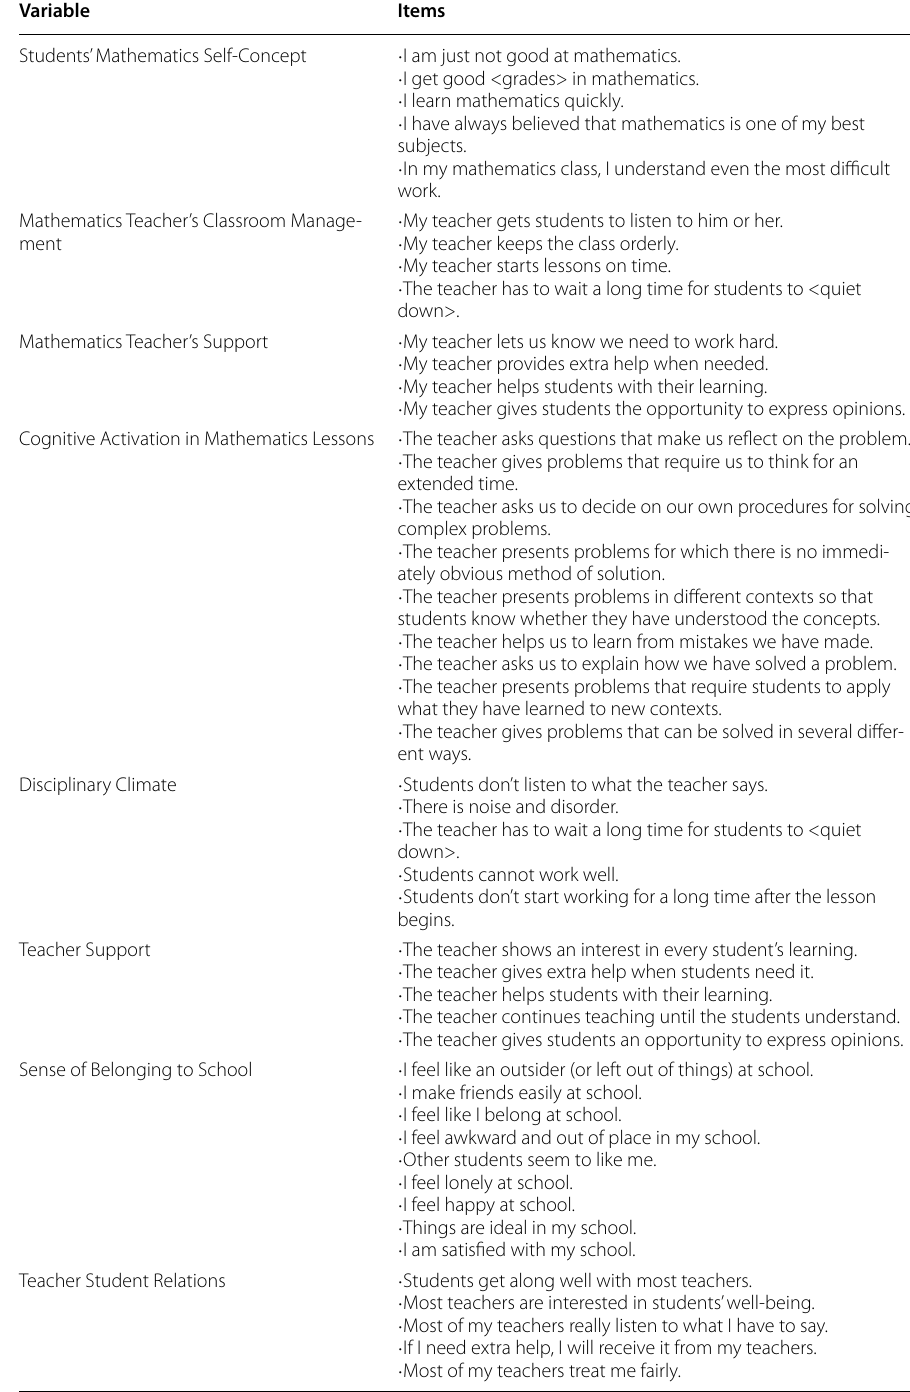
Table 7 The List of Items which were used to create the variable of interest by PISA (OECD, 2014)